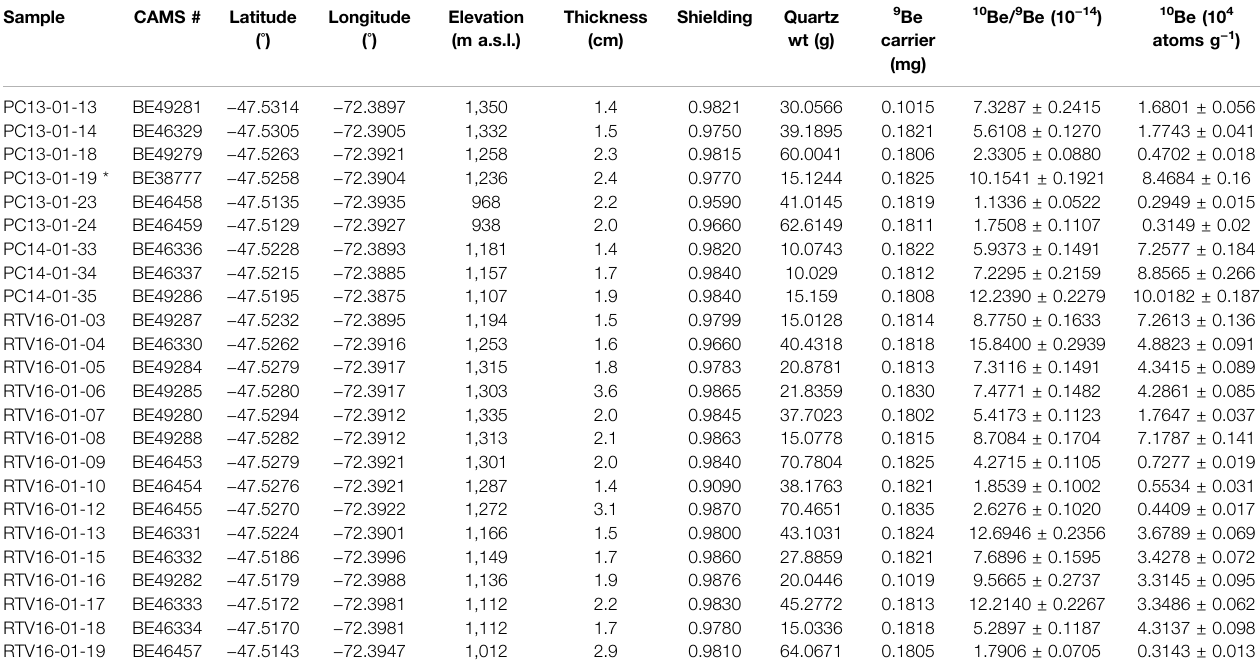
TABLE 1 | Geographical and analytical data for samples from the Río Tranquilo valley.